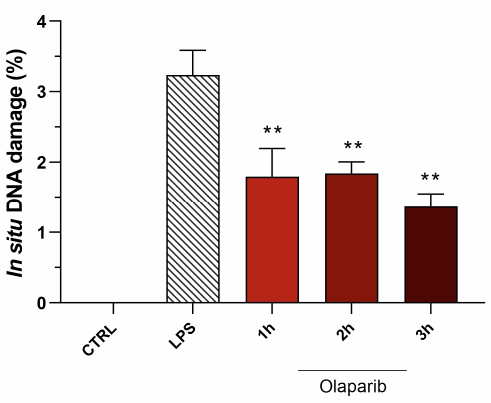
Figure 20. Effect of olaparib post-treatment on DNA damage in the lung in a murine model of ALI. C57Bl/6 mice received either PBS (30 µL) or LPS (50 µg in 30 µL PBS) by intratracheal instillation in the absence or presence of 10 mg/kg olaparib, delayed to 1, 2, or 3 h post-LPS. After 24 h, DNA damage in the lung was quantified by the TUNEL assay. ** p < 0.01 indicates the beneficial effect of olaparib against DNA damage in LPS-treated animals. Data are shown as mean ± SEM, n = 8–12/group. Inhibition of IL-β levels in the BAL (but not the inhibition of TNFα) was maintained